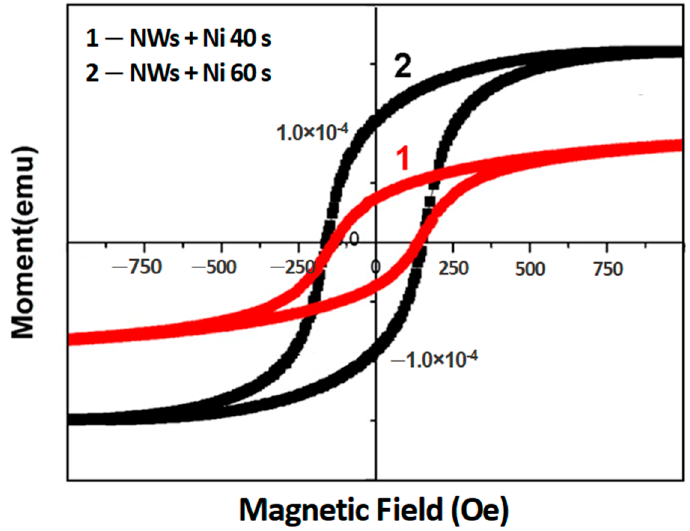
Figure 6. Hysteresis loops measured on GaAs/Ni core-shell arrays after Ni deposition for 40 s (curve 1) and 60 s (curve